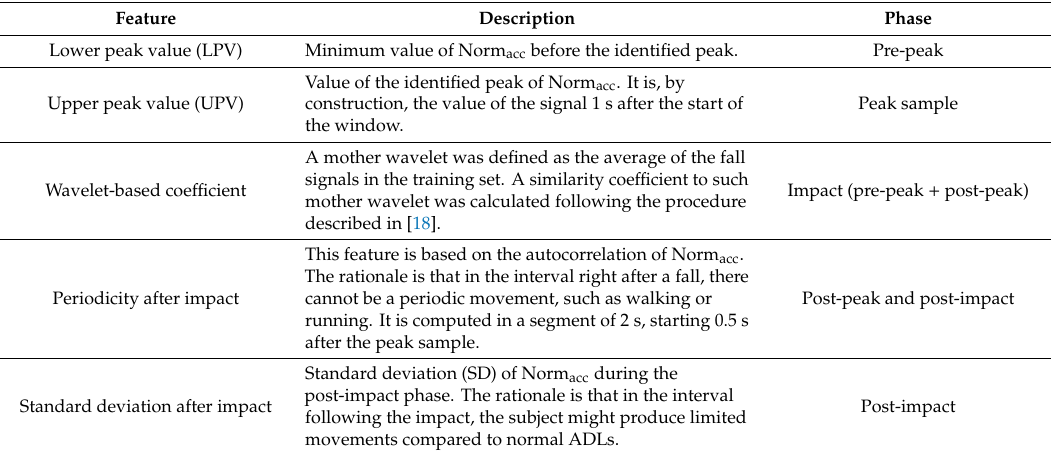
Table 1. Extracted